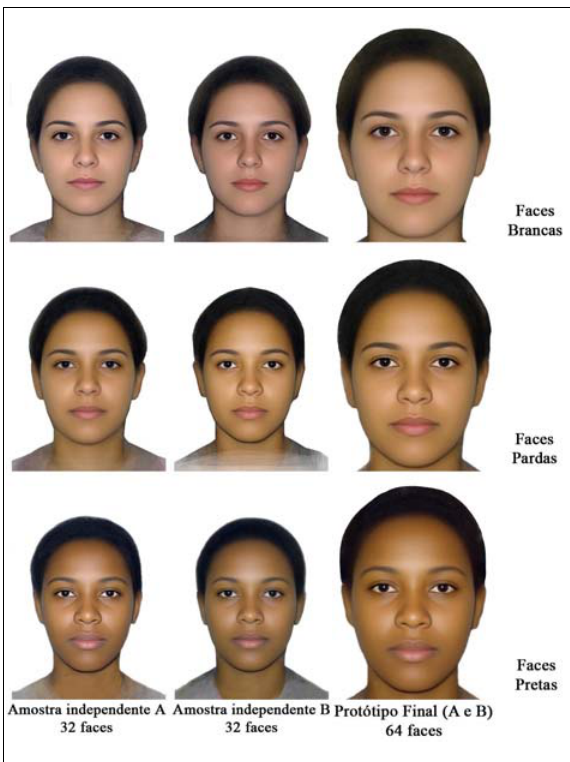
Figura 3 . Protótipos faciais masculinos. As duas primeiras fi- guras das colunas à esquerda são resultado da fusão de 32 foto- grafias de amostras independentes. As figuras da terceira coluna é o resultado da fusão das figuras das colunas anteriores e estas foram tomadas como o protótipo facial de cada uma das cores (ou raças)